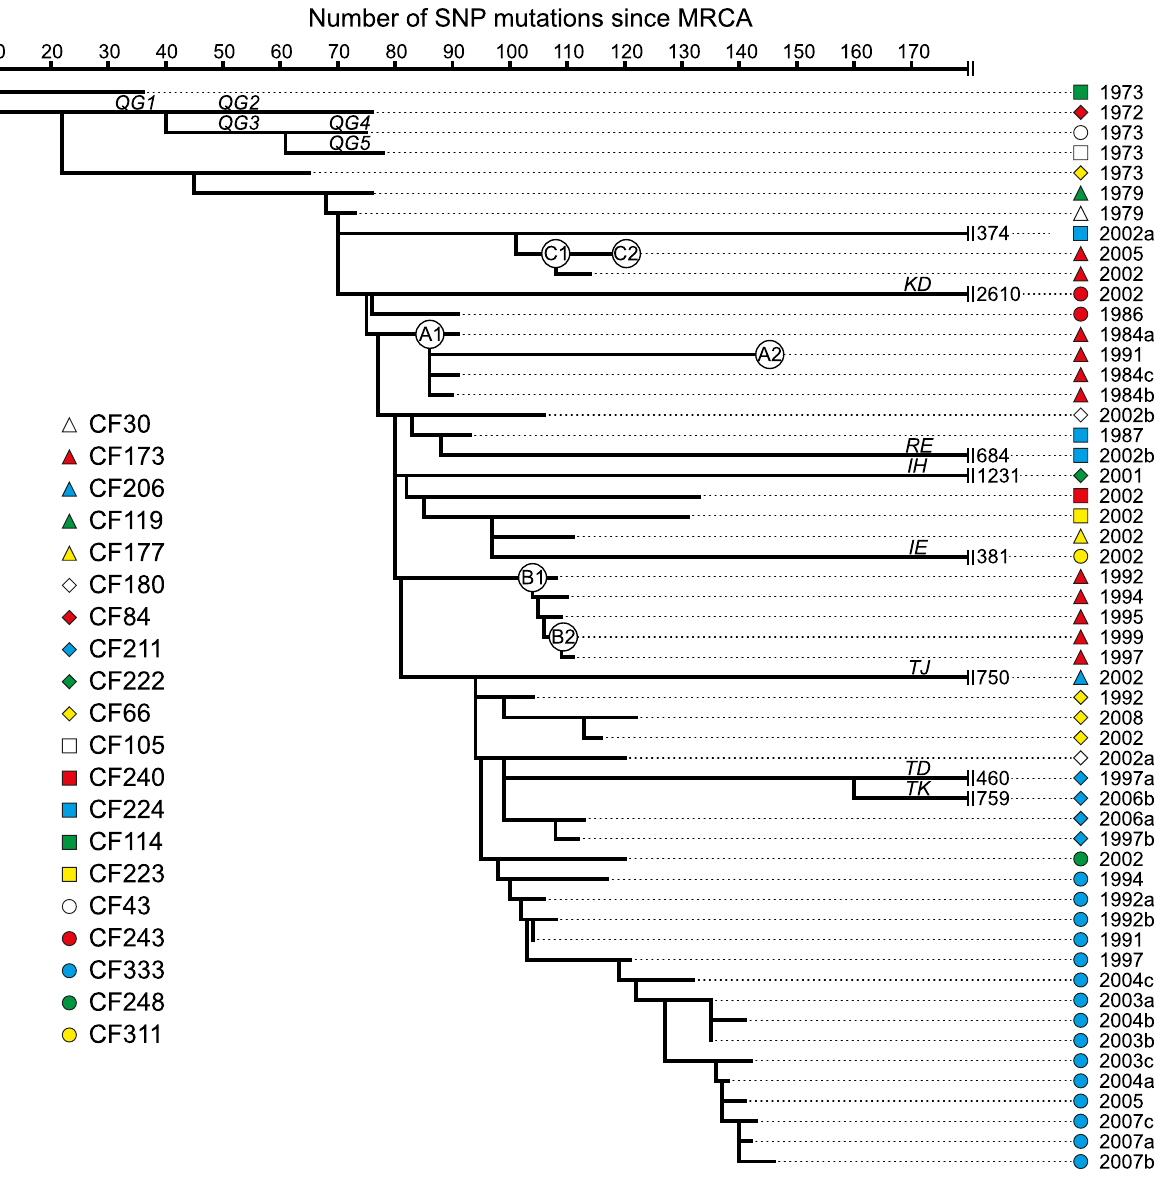
Figure 2. Maximum-parsimonious reconstruction of the phylogeny of the P.aeruginosa DK2 clones. The phylogenetic tree is based on 7,326 SNPs identified from whole-genome sequencing, and lengths of branches are proportional to the number of mutations. Outlier isolate CF510- 2006 [9] (not shown) was used as an outgroup to determine the root of the tree. Branches leading into mutS , mutL , or, mutY hypermutable isolates are named as indicated by italic letters. Statistics on mutations accumulated in the specific branches are summarized in Table 1. Circles labeled A1, A2, B1, B2, C1, and C2, respectively, denotes the position of the first and last genotype of each of the DK2 sub-lineages A, B, and C which were observed to have infected patient CF173.